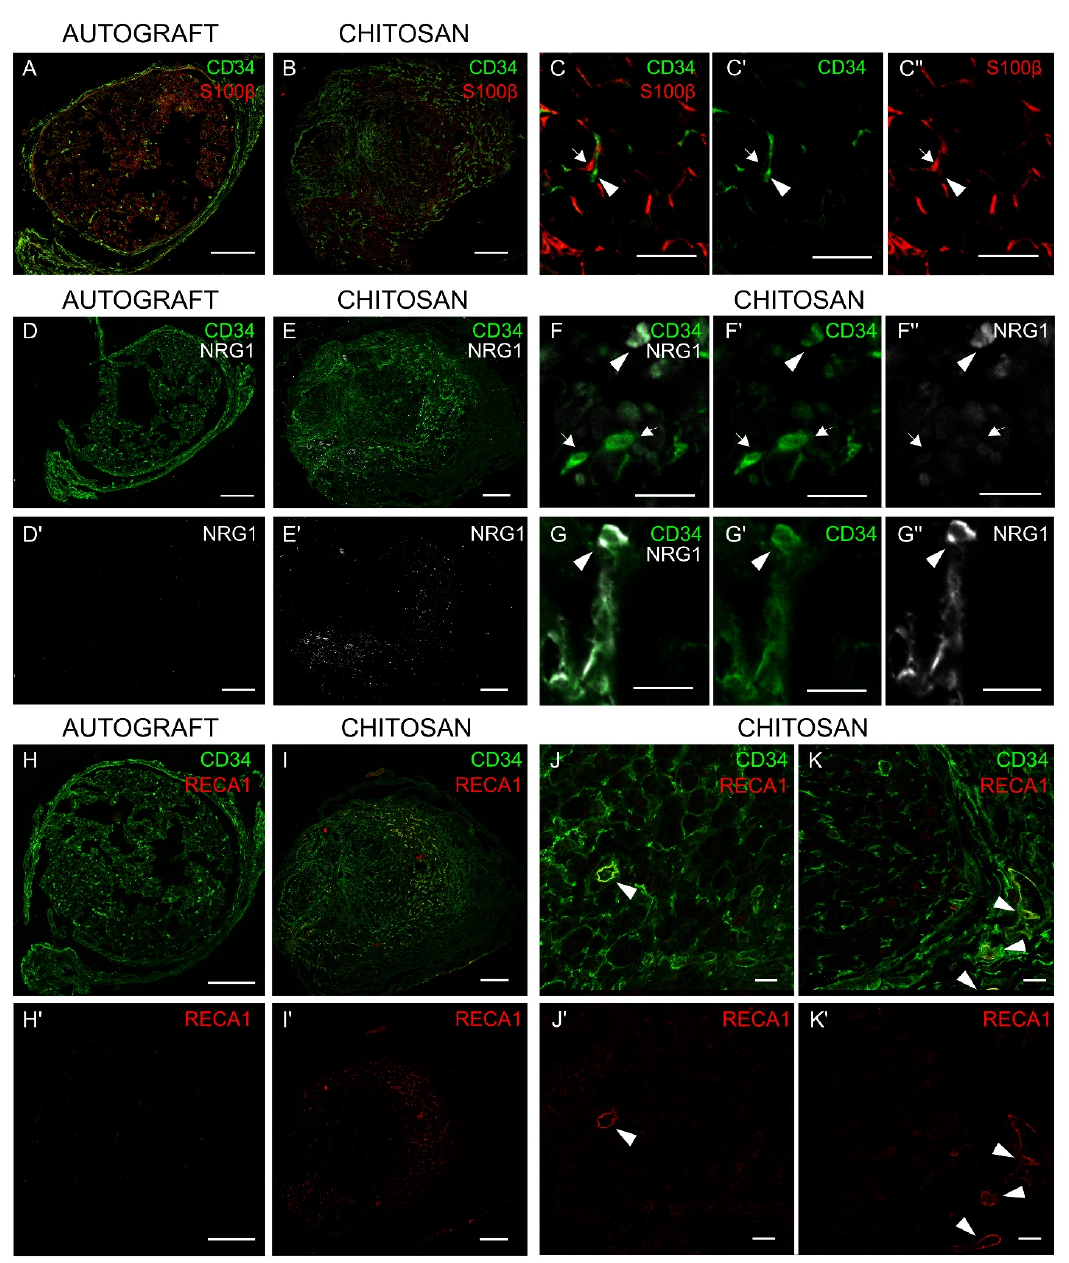
Figure 4. Nerve fibroblasts express NRG1 in vivo. Cross section of median nerves analyzed 7 days after repair with an autograft ( A, D, D’, H, H ’) or with a chitosan conduit ( B, E, E’, I, I’ ): ( A,B ) double-stained with S100 β (Schwann cell marker, red) and CD34 (fibroblast marker, green). ( C, C’, C” ) Images at higher magnification show the absence of colocalization between S100 β and CD34; fibroblasts are pointed out by arrow heads, Schwann cells by arrows. ( D,E ) double-stained with CD34 (green) and NRG1 (white) or ( D’,E’ ) single-stained with NRG1; ( D’ ) and ( E’ ) highlight di ff erent levels of NRG1 expression in the two di ff erent experimental models (higher in the chitosan group). ( F, F’, F” and G, G’, G” ) Images at higher magnification show some CD34 + cells positive only to CD34 (arrow) and some CD34 + cells also positive to NRG1 (arrow head). ( H,I ) double-stained with CD34 (fibroblast and endothelial cell marker, green) and RECA1 (endothelial cell marker, red) or ( H’,I’ ) single-stained with RECA1; ( H’ ) and ( I’ ) highlight di ff erent levels of RECA1 expression in the two di ff erent experimental models (higher in